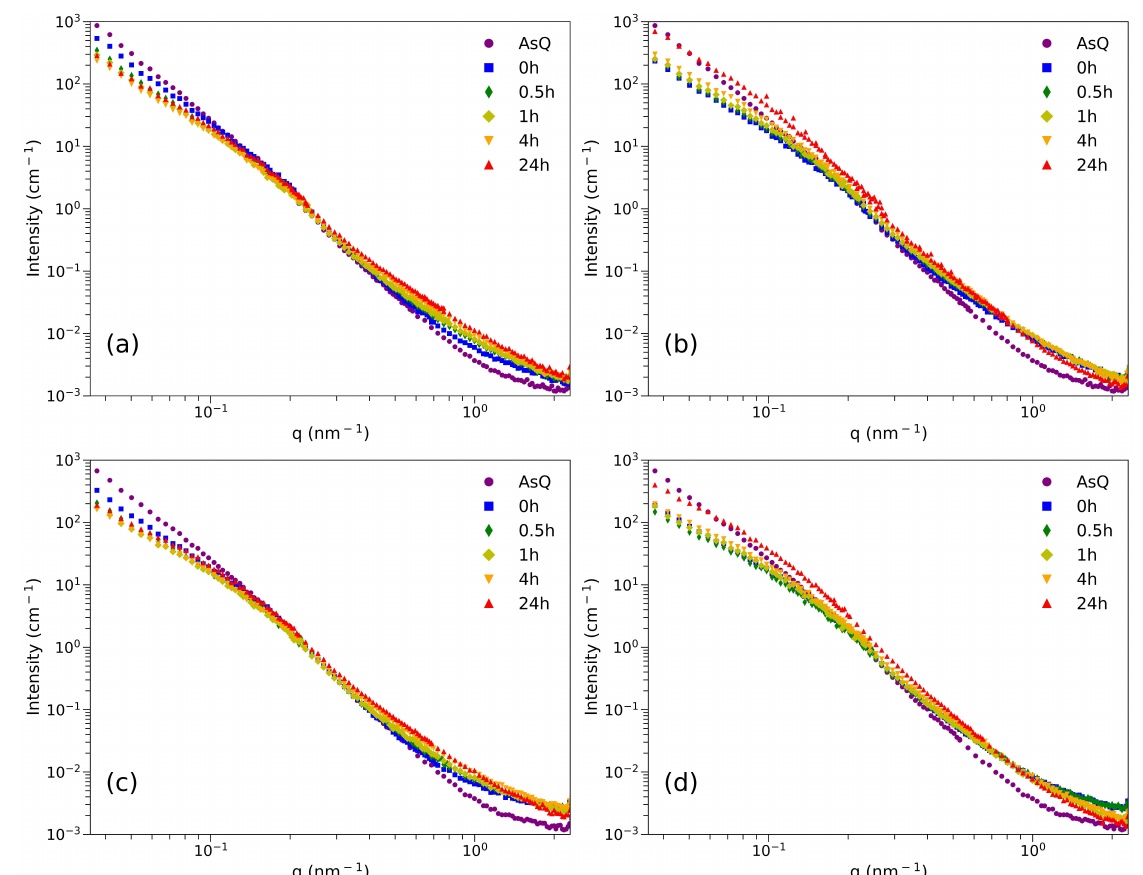
Figure 7 Figure 8. Measured SANS data of tempered samples. ( a ) Material A at 550 ◦ C, ( b ) Material A 600 ◦ C, ( c ) Material B at 550 ◦ C, and ( d ) Material B at 600 ◦